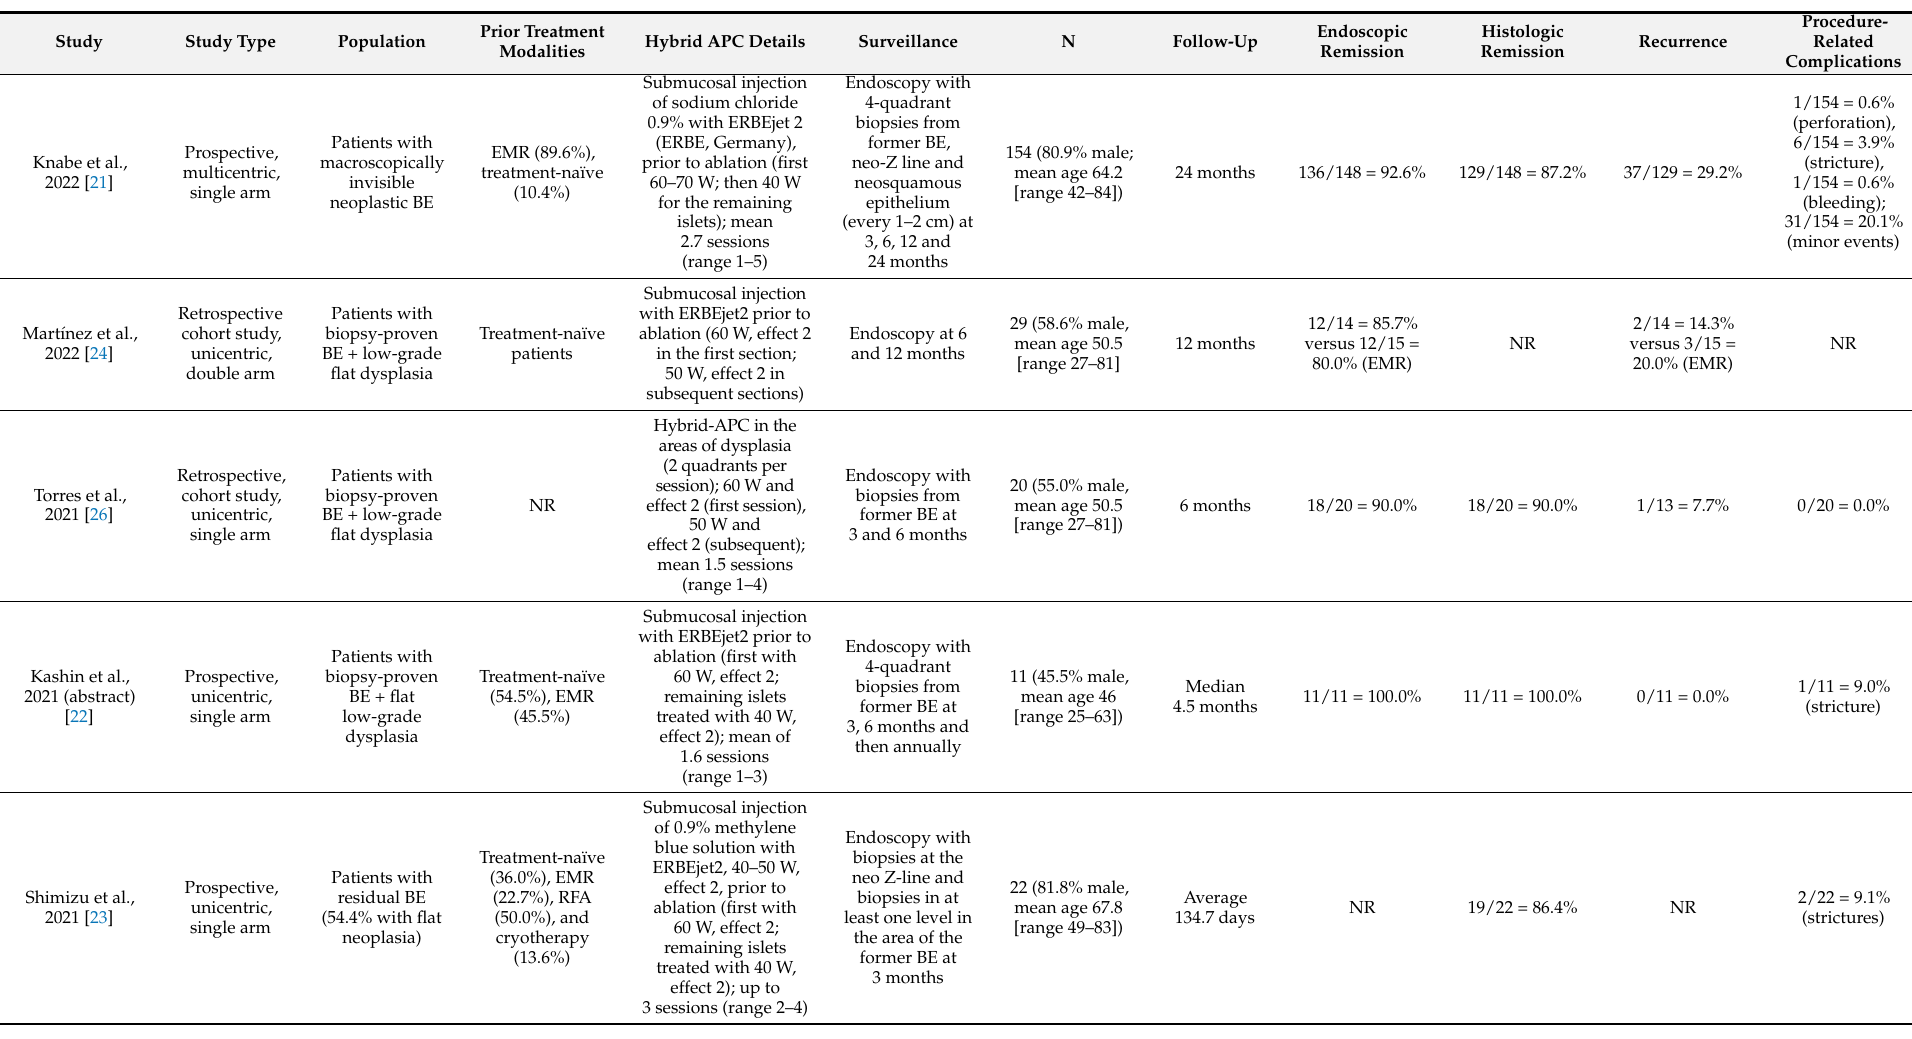
Table 1. Summary of the studies evaluating hybrid argon plasma coagulation (hAPC) for Barrett esophagus (BE) ablation. Barrett esophagus (BE); endoscopic mucosal resection (EMR); hybrid argon plasma coagulation (hAPC); not reported (NR); radiofrequency ablation (RFA); watt